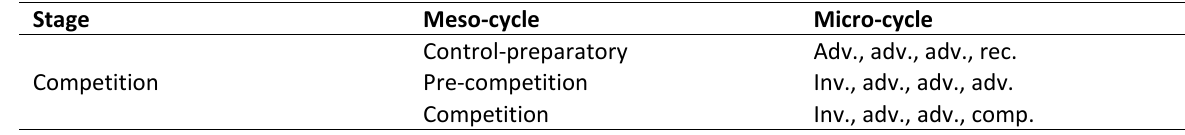
Table 2. Scheme of CG training in competition period